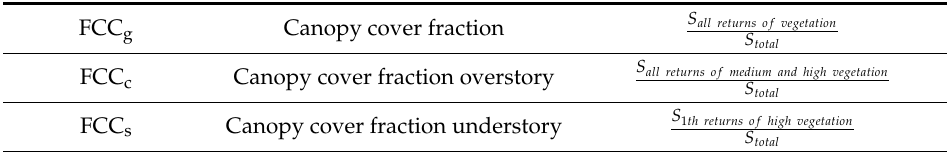
Table 4. Calculations of canopy cover fraction (FCC)